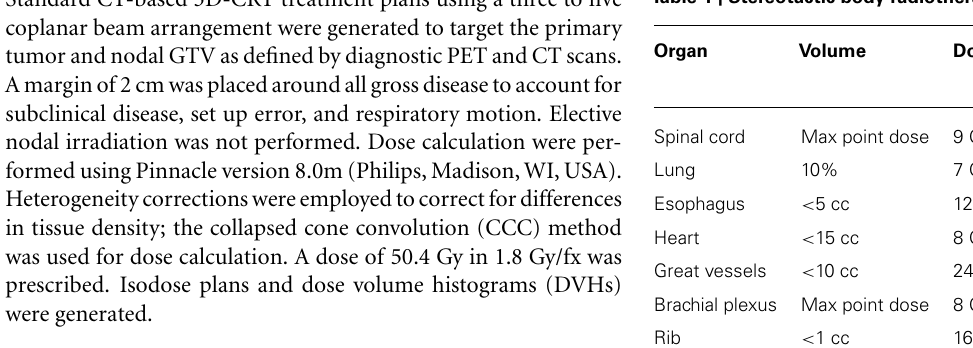
Table 1 | Stereotactic body radiotherapy boost dose constraints.